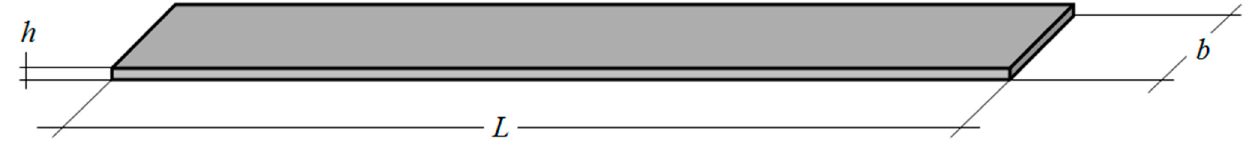
Figure 3. Steel beam geometrical